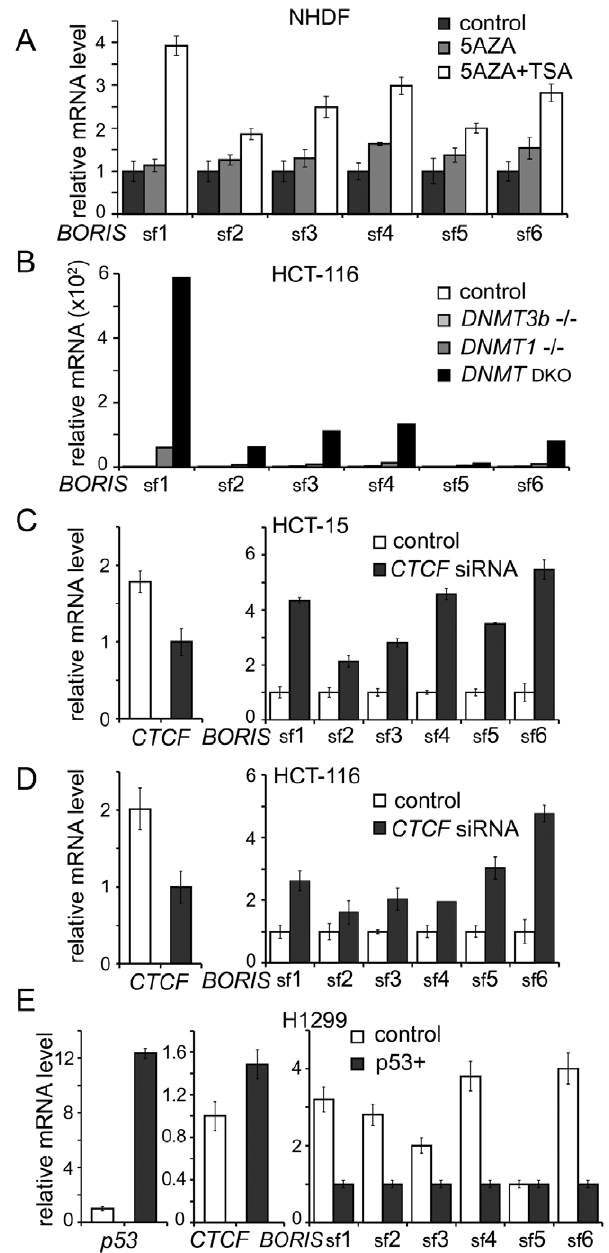
Figure 9. CpG methylation, p53 and CTCF are responsible for BORIS isoform repression in somatic cells. ( A ) BORIS isoform expression is activated by 5-aza-dC treatment of Normal Human Dermal Fibroblasts (NHDF). qPCR analyses were done on total RNA extracted from NHDF treated with 5-aza-dC alone or in combination with Trichostatin A (TSA). Data were analyzed by comparing Ct values and normalized to the control (untreated cells). ( B ) A ctivation of BORIS isoforms transcription correlates with genomic DNA demethylation. qPCR was used to quantify BORIS subfamily expression in 4 types of HCT116 colon cancer cell lines: the HCT116 parental cell line, two single knockouts for DNMT1–/– and DNMT3B–/– and the double knockout (DNMT1 2 / 2 ,DNMT3b 2 / 2 ) (DKO). Data were normalized to BORIS isoform levels in the HCT116 parental cell line. ( C ) and ( D ) Knockdown of CTCF in two colon cancer cell lines results in the activation of all BORIS subfamilies. qPCR was done on RNA extracted from HCT-15 and HCT-116 parental cells, and from the same cells treated with siRNA against CTCF for 72 hours. CTCF downregulation was confirmed and BORIS upregulation was observed in both cell lines by qRT-PCR.